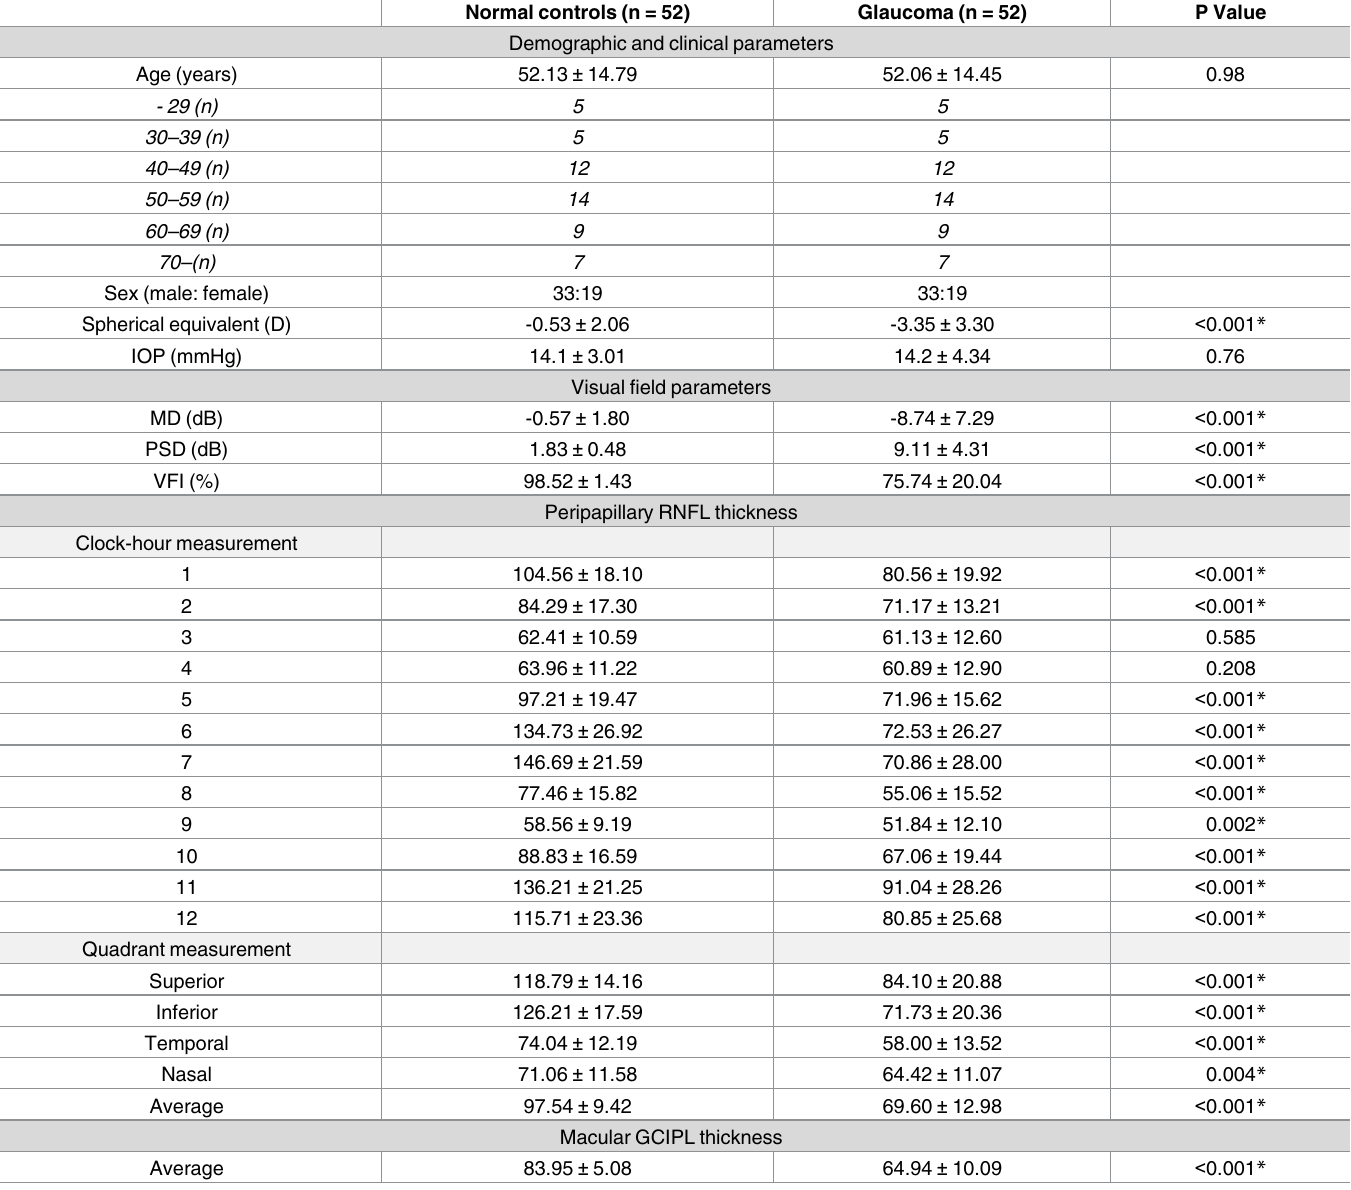
Table 1. Clinical characteristics of the study